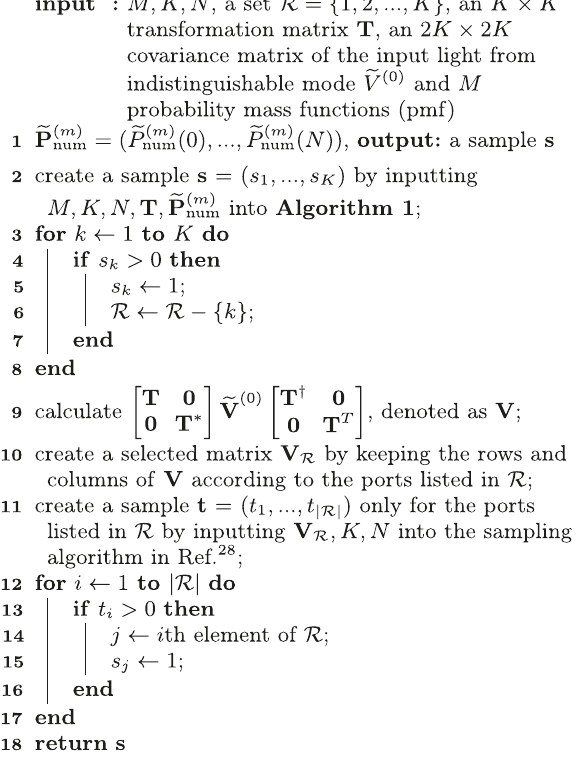
Algorithm 2 . Sampling algorithm of partially distinguishable GBS with threshold detectors.